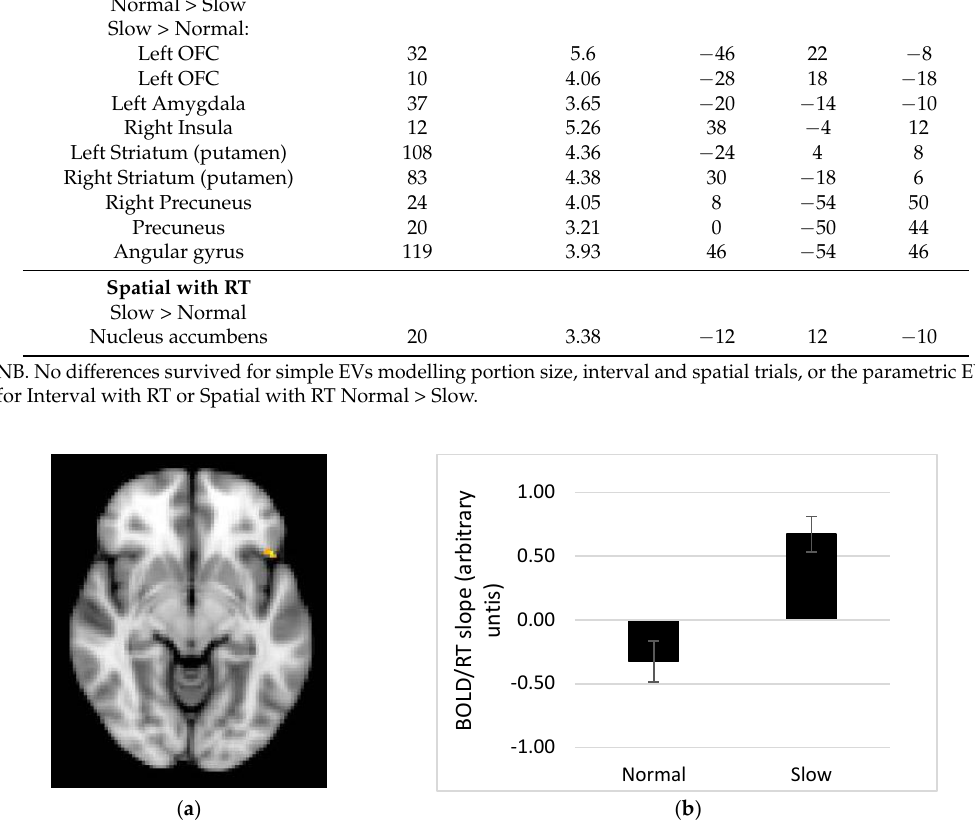
Figure 5. ( a ) Cluster of voxels in the OFC showing a stronger relationship between the BOLD response in this region shown and response times for portion size trials in the slow rate group compared to the normal rate group. This region may show a strong association with memory for eating as linked to task performance. ( b ) Mean % BOLD signal change for the analysis extracted for this region of the OFC for each group (error bars show S.E. mean). The slow group show a steeper BOLD/RT relationship in the region shown in ( a ).